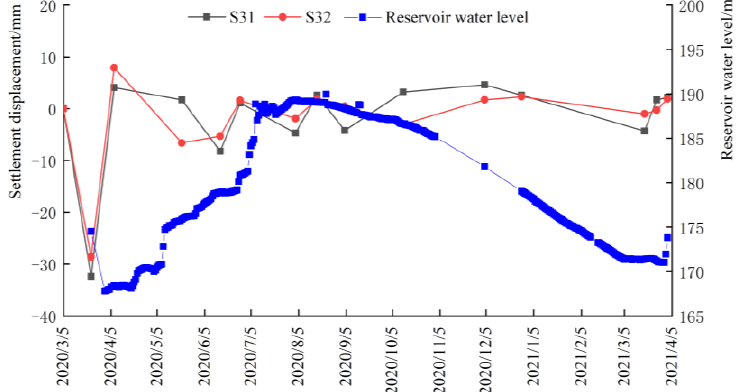
Figure 11. 2 # section settlement displacement duration curve (downward is +, upward is − ).